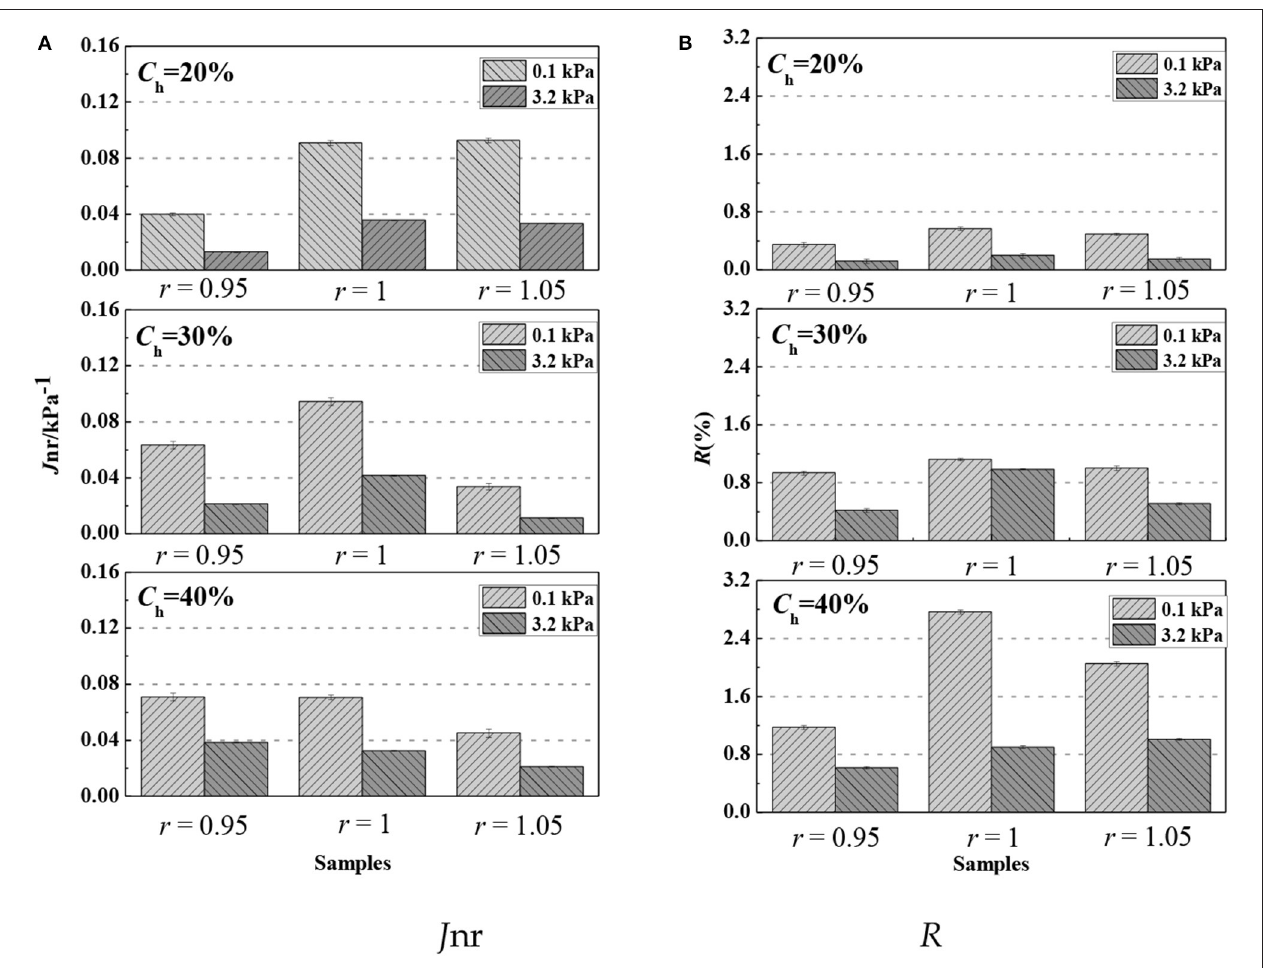
FIGURE 32 | MSCR-based evaluation of polyester-based TPU-modified asphalt. (A) J nr. (B) R .